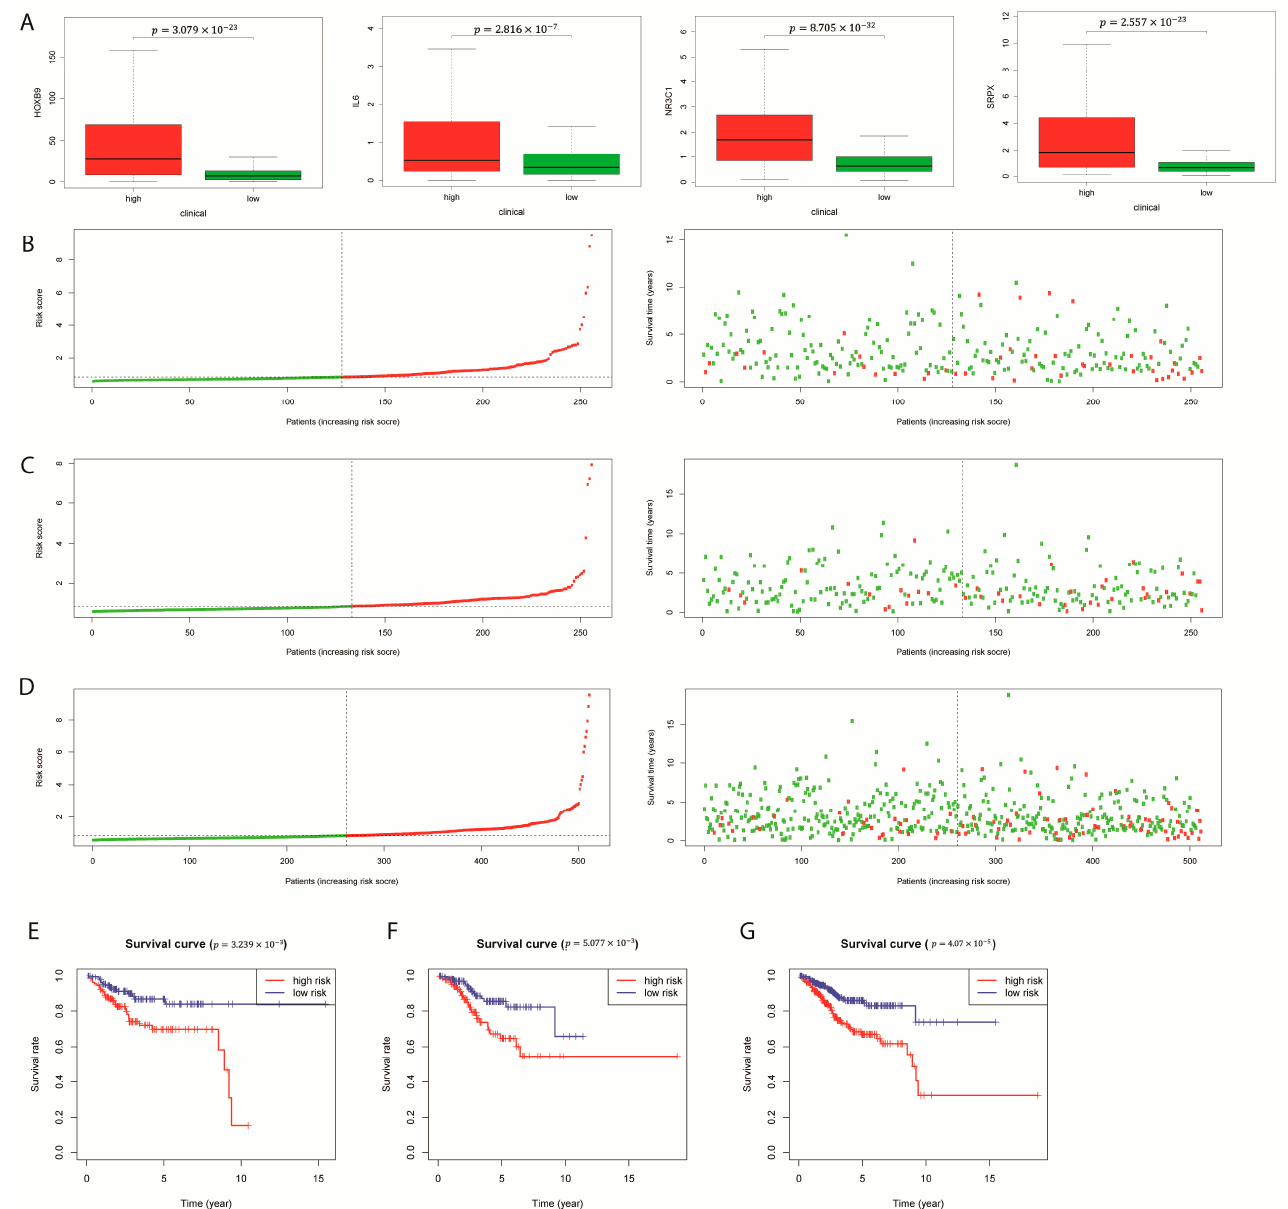
Figure 2. Development of prognostic model combining hypoxia-related gene signature and clinical factors. ( A ) mRNA Expression of gene HOXB9, IL6, NR3C1, and SRPX compared between low and high-risk groups. ( B – D ) The risk score rank ( left ) and distribution of survival status ( right ) of the four genes in the training set, testing set, and entire set. Green for alive and red for dead in high-risk groups. ( E – G ) Kaplan-Meier OS for high-risk group and low-risk group in the training set, testing set, and entire set ( from left to right ).